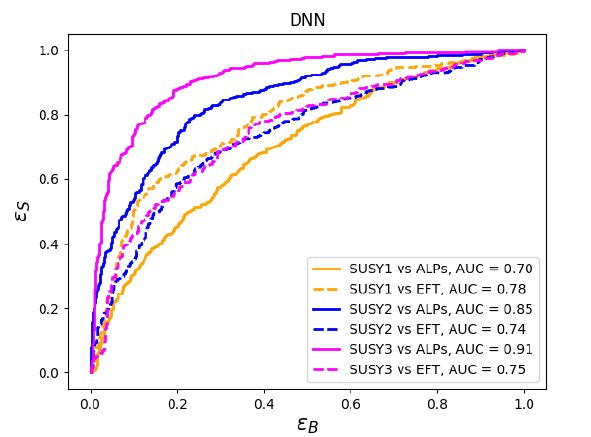
Figure 11: ROC curves (DNN with 2D histograms, r = 20) for SUSY WIMP versus signal for the dijet detector-level simulation. For these plots, 50K events are used for each